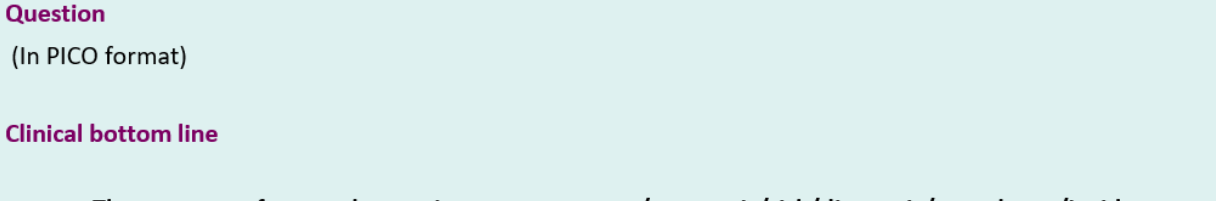
Figure 1: Clinical bottom line submission template